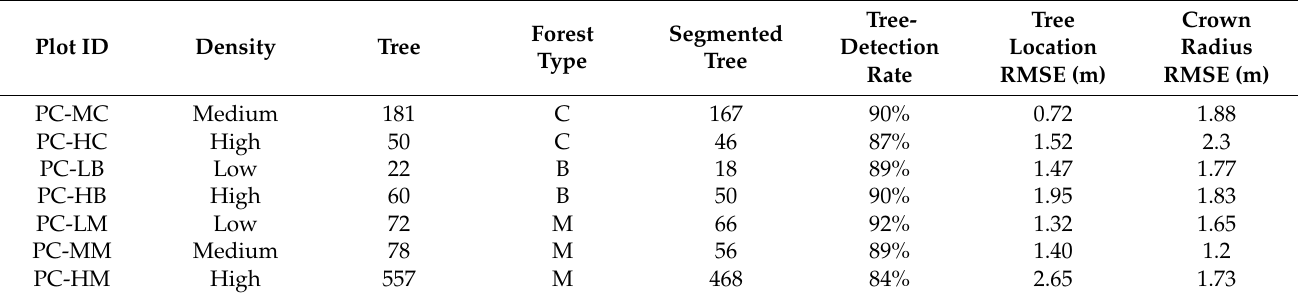
Table 5. Characteristics of the individual trees for forest plots.